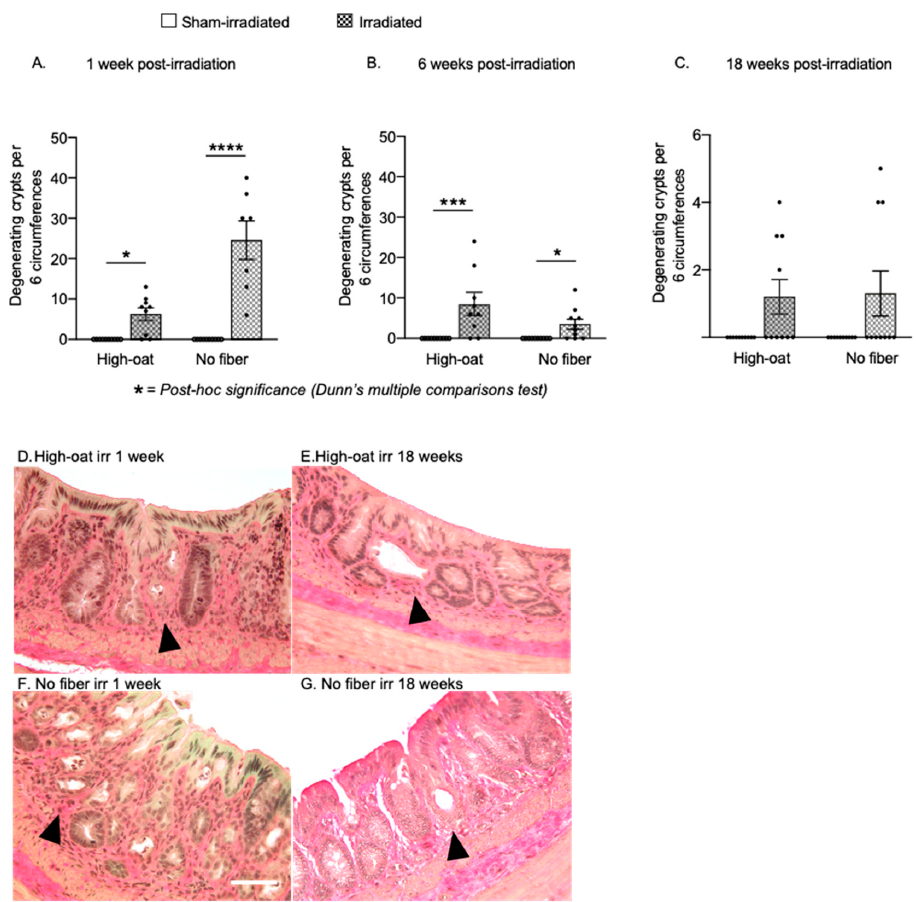
Figure 2. Number of degenerating crypts at 1 week, 6 weeks and 18 weeks after irradiation. Degenerating crypts were never seen in sham-irradiated animals. ( A ). More crypt degeneration was seen in the fiber-deprived animals (“No fiber”) than the oat-fed animals (“High-oat”) at one week after irradiation. * p = 0.0191 and **** p < 0.0001. ( B ). Although the initial high rate of crypt degeneration in the irradiated No-fiber mice had declined by 6 weeks post-irradiation, crypt degeneration still occurred in both diet groups. *** p = 0.0008 and * p = 0.0205. ( C ). At 18 weeks, the High-oat and No- fiber irradiated mice both had similar and low numbers of degenerating crypts. ( D – G ). Micrographs (40 × magnification) of colorectal mucosa stained with Verhoeff’s Elastic Stain. Arrowheads depict examples of degenerating crypts. Scale bar 50 µ m. Data are shown as mean ±